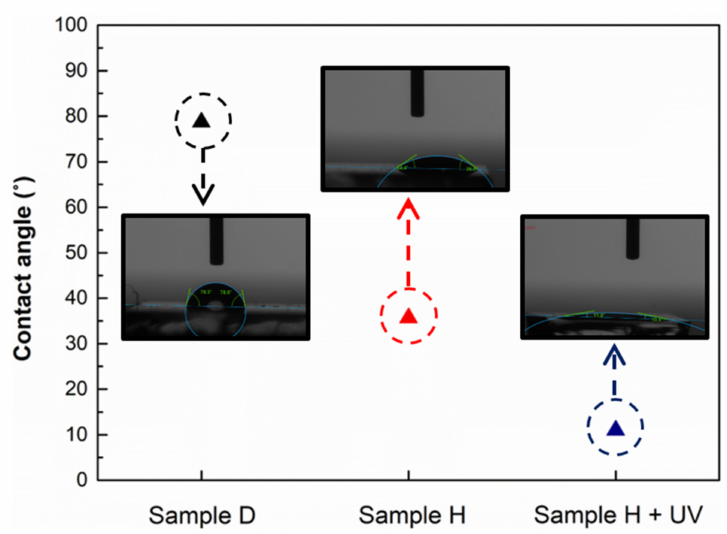
Figure 3. Variation in water contact angle with thermal treatment and UV irradiation (Sample D: 150 W, 60 min, R.T., Sample H: 150 W, 60 min, 500 ◦ C, Sample H + UV: Sample H and UV